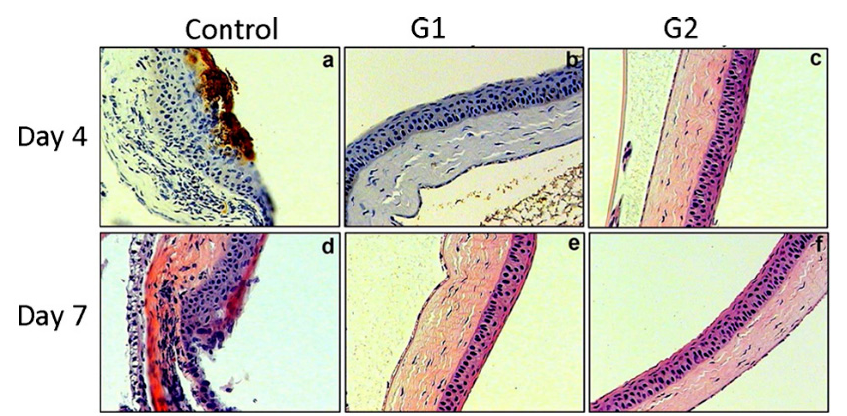
Figure 4. A mouse model of corneal keratitis was given 100 µ L of 0.5mM of G1 (peptides with alternating charges), G2 (peptides with repetitive charges), and designated peptide (control) as a prophylactic eye drop followed by the inoculation of HSV-1. Immunohistochemistry was carried out using anti-HSV-1 glycoprotein D (gD) polyclonal antibody on day 4 and day 7 post-infection to detect the HSV-1 gD expression in the cornea. ( a ) chronic inflammation was observed together with significant brown staining in the pretreated cornea with control on day 4, which was indicating the expression of HSV-1 gD; ( b ) on day 4, HSV-1 gD staining was not detected in the cornea pretreated with G1 peptide; ( c ) on day 4, HSV-1 gD staining was not detected in the cornea pretreated with G2 peptide; ( d ) the staining was disappeared in the cornea pretreated with control on day 7 but the damage of the corneal epithelium was observed; ( e ) on day 7, HSV-1 gD staining was not detected in the cornea pretreated with G1 peptide and the corneal epithelium remained intact; ( f ) on day 7, HSV-1 gD staining was not detected in the cornea pretreated with G2 peptide and the corneal epithelium remained intact. The results indicated G1 and G2 significantly blocked the entry of HSV-1, adapted with permission from [85], American society for biochemistry and molecular biology, 2011.